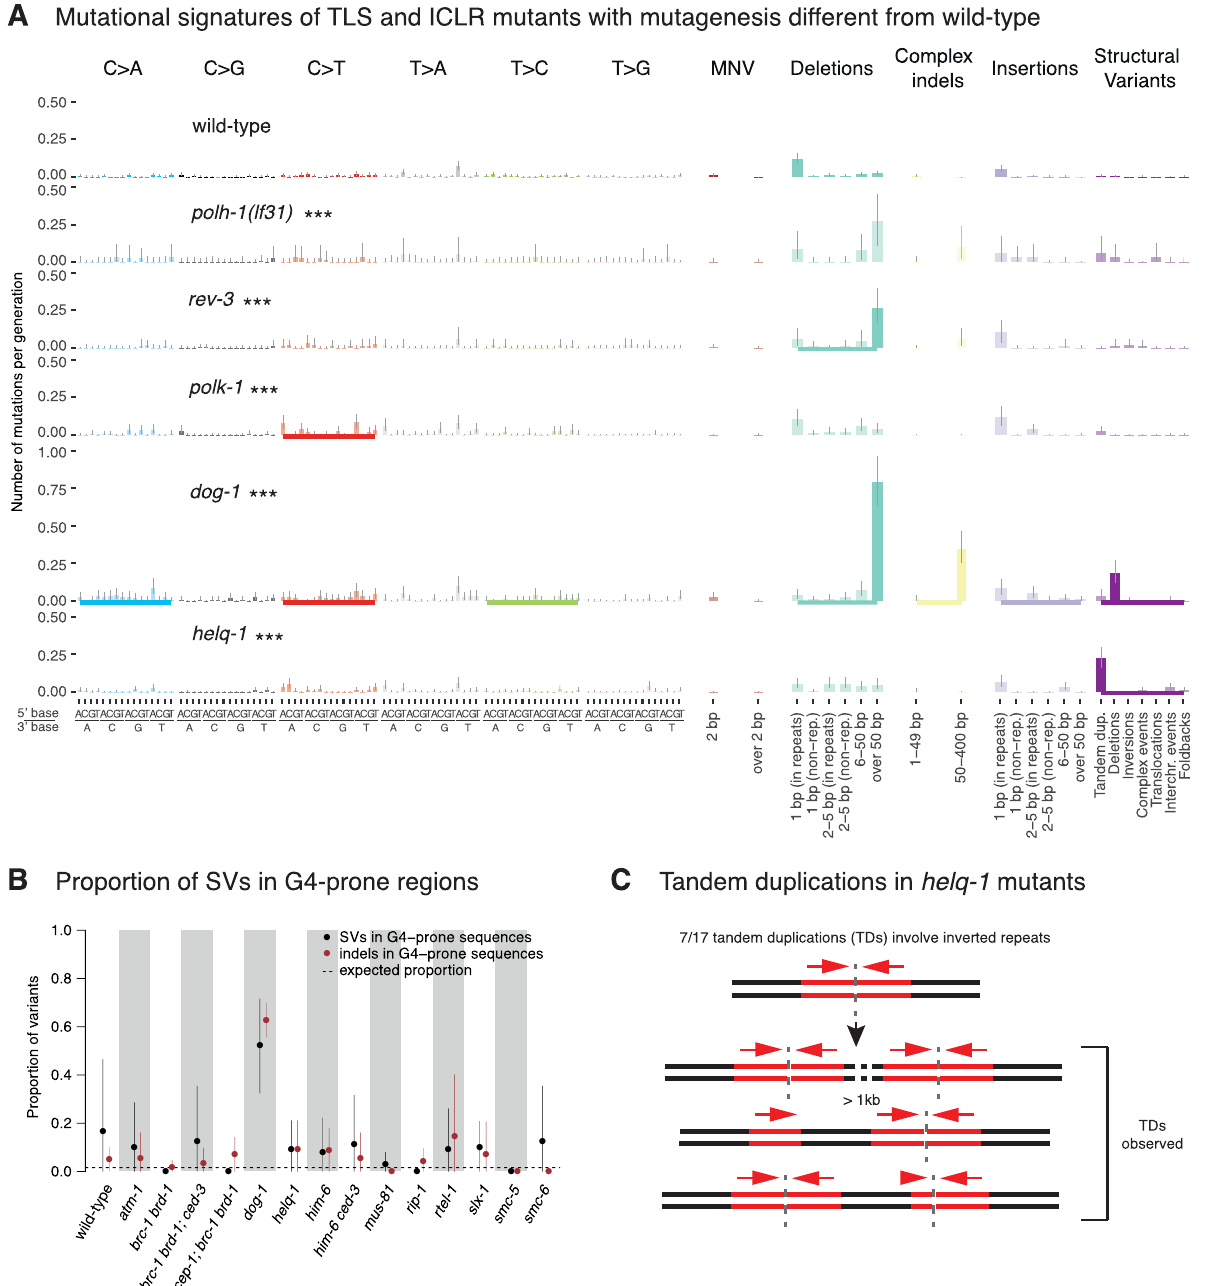
Fig 5. Signatures and genomic features of mutations in TLS and ICLR deficient C . elegans . A. Mutational signatures of TLS and ICLR mutants that exhibited statistically significant differences to wild-type mutation rates displayed in numbers of mutations per generation. Same layout as Fig 4A. B . Proportion of indels (brown) and SVs (black) in G-rich regions in wild-type and across genotypes with elevated rates of SVs. Dotted line represents the proportion of variants falling into these regions as expected by chance. C . Tandem duplications (TDs) in helq-1 mutants. An analysis